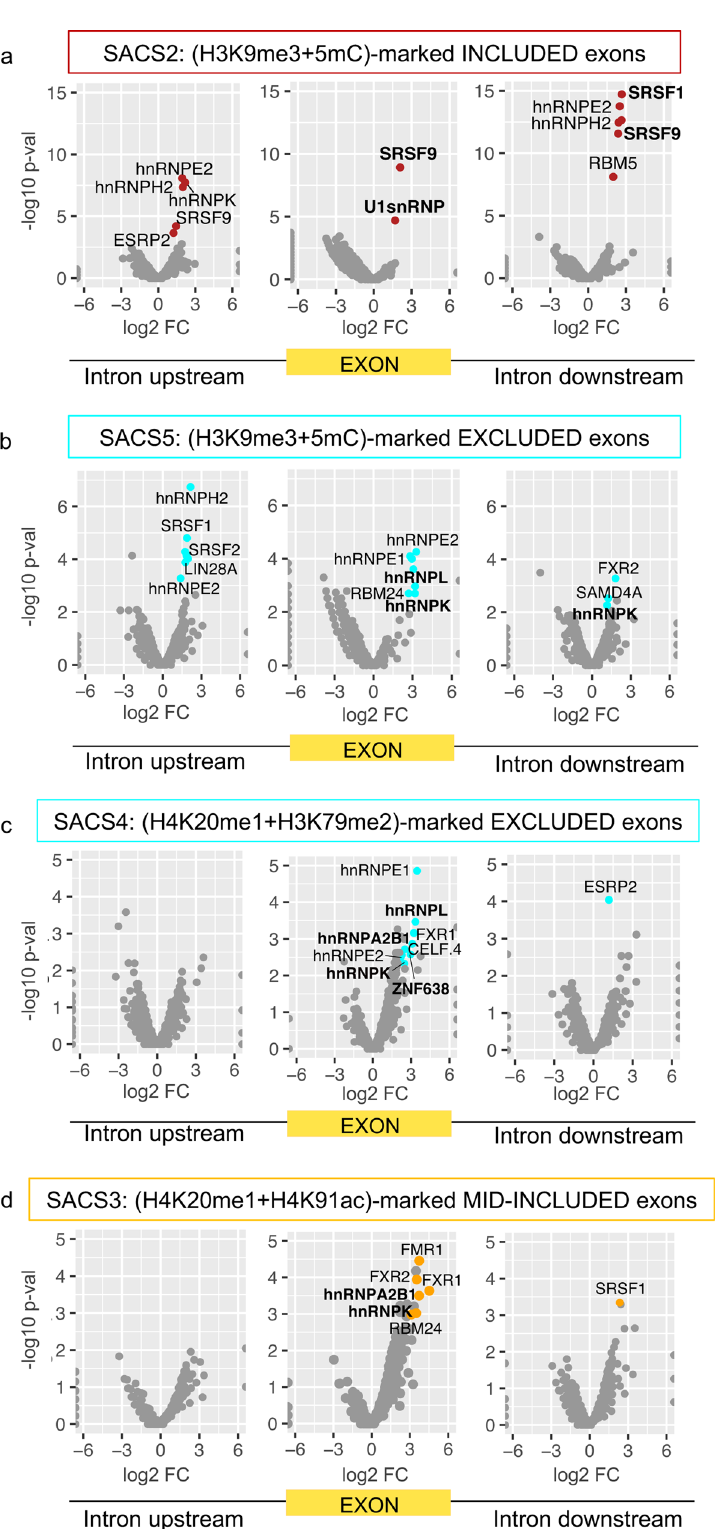
Fig. 6 SACS are de fi ned by speci fi c RNA-binding protein (RBP) motifs. a – d Volcano plots of the scanned RBP motifs and 5mers in the upstream intron (left), chromatin-marked exon (middle) and downstream intron (right) for a included H3K9me3 + 5mC-marked exons (SACS2), b excluded H3K9me3 + 5mC-marked exons (SACS5), c excluded H4K20me1 + H3K79me2-marked exons (SACS4) and d mid-included H4K20me1 + H4K91ac-marked exons (SACS3). Coloured dots correspond to motifs with adjusted p -value < 0.01 and Benjamini and Hochberg false discovery rate FDR < 0.05. X axis represents the log2 fold enrichment (FC) of each motif compared to non-marked alternatively spliced events sequences. Y axis represents the − log10 adjusted p -value of the enrichment. FDR and associated adjusted p -value were calculated from n = 152 H4K20me1 + H3K79me2 excluded exons, n = 89 H3K9me3 + 5mC excluded, n = 143 H4K20me1 + H4K91ac mid-included exons, n = 142 H3K9me3 + 5mC included exons, n = 600 non chromatin-marked excluded exons and n = 600 non chromatin-marked included